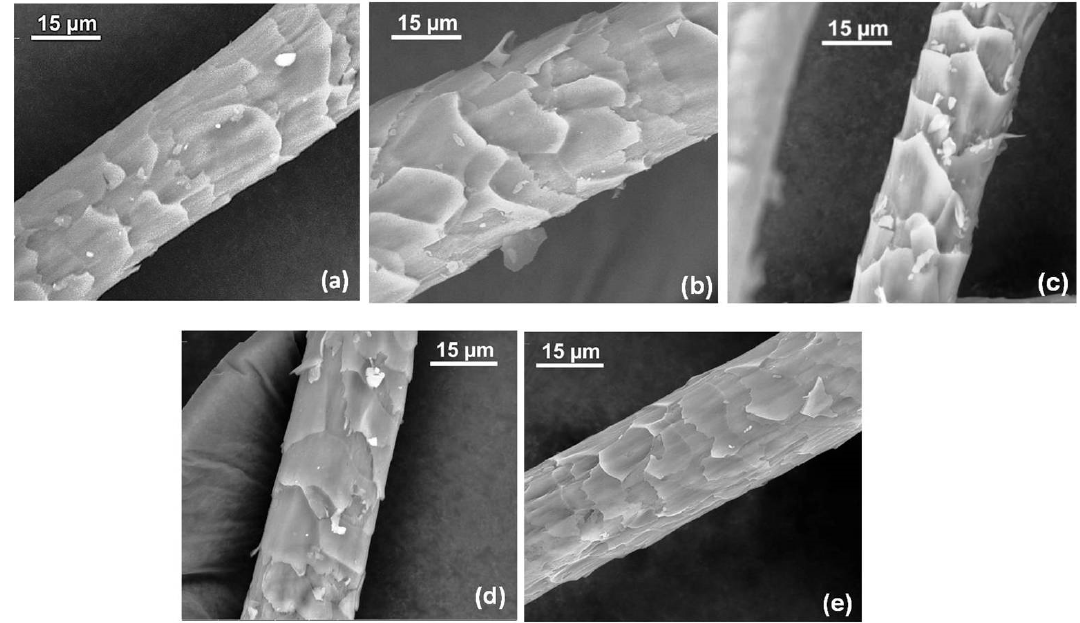
Figure 9. Scale morphology of unscoured wool fibres: ( a ) untreated, ( b ) 80 W 6 m 50 sccm, ( c ) 80 W 20 m 50 sccm, ( d ) 150 W 6 m 12 sccm, and ( e ) 150 W 20 m 12 sccm.